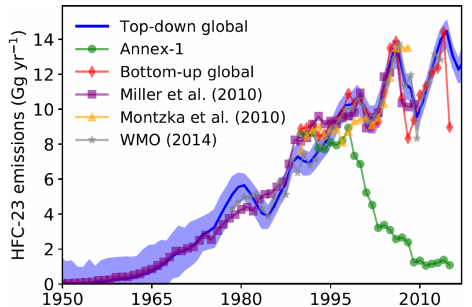
Figure 3. Global emissions of HFC-23 calculated from the AGAGE 12-box model (blue line and shading, 1 σ uncertainty). Data are plotted as annual mean values, centred on the middle of each year. The purple line shows bottom-up HFC-23 estimates of emissions from Miller et al. (2010), the yellow line HFC-23 emissions esti- mates from Montzka et al. (2010) and the grey line from Carpen- ter and Reimann (2014). The green line shows emissions reports by Annex-1 countries. The red line shows the bottom-up estimated global emissions developed here and discussed in Sect.